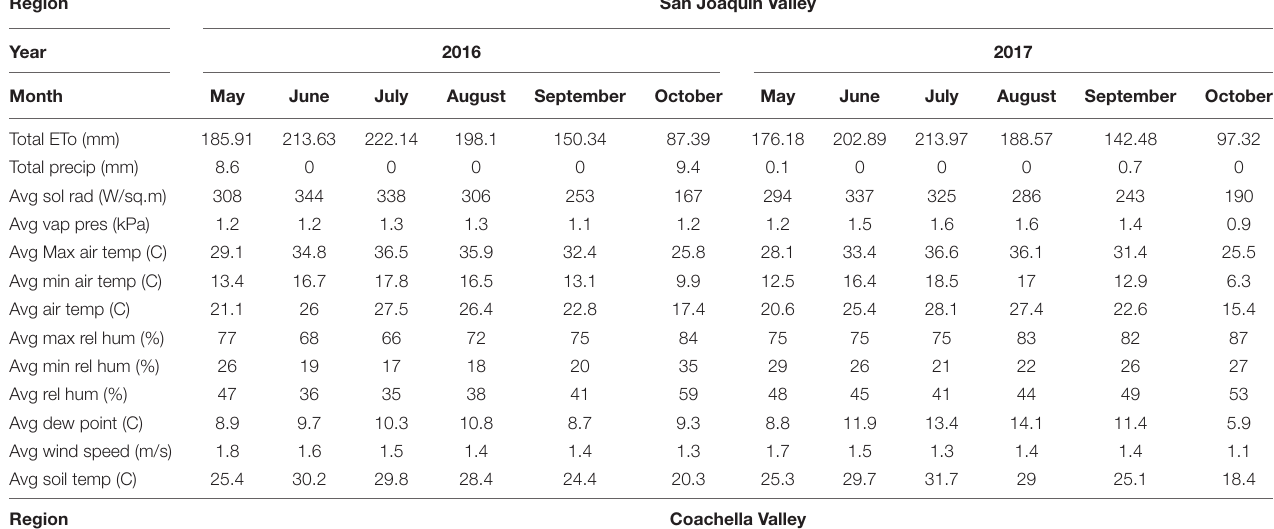
TABLE 1 | Monthly climate data reported by CIMIS system (https://cimis.water.ca.gov) in both San Joaquin and Coachella Valleys in the 2016 and 2017 growing seasons. Region San Joaquin